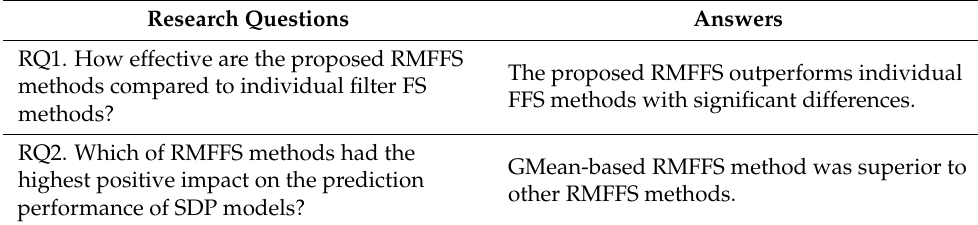
Table 7. Answers to Research